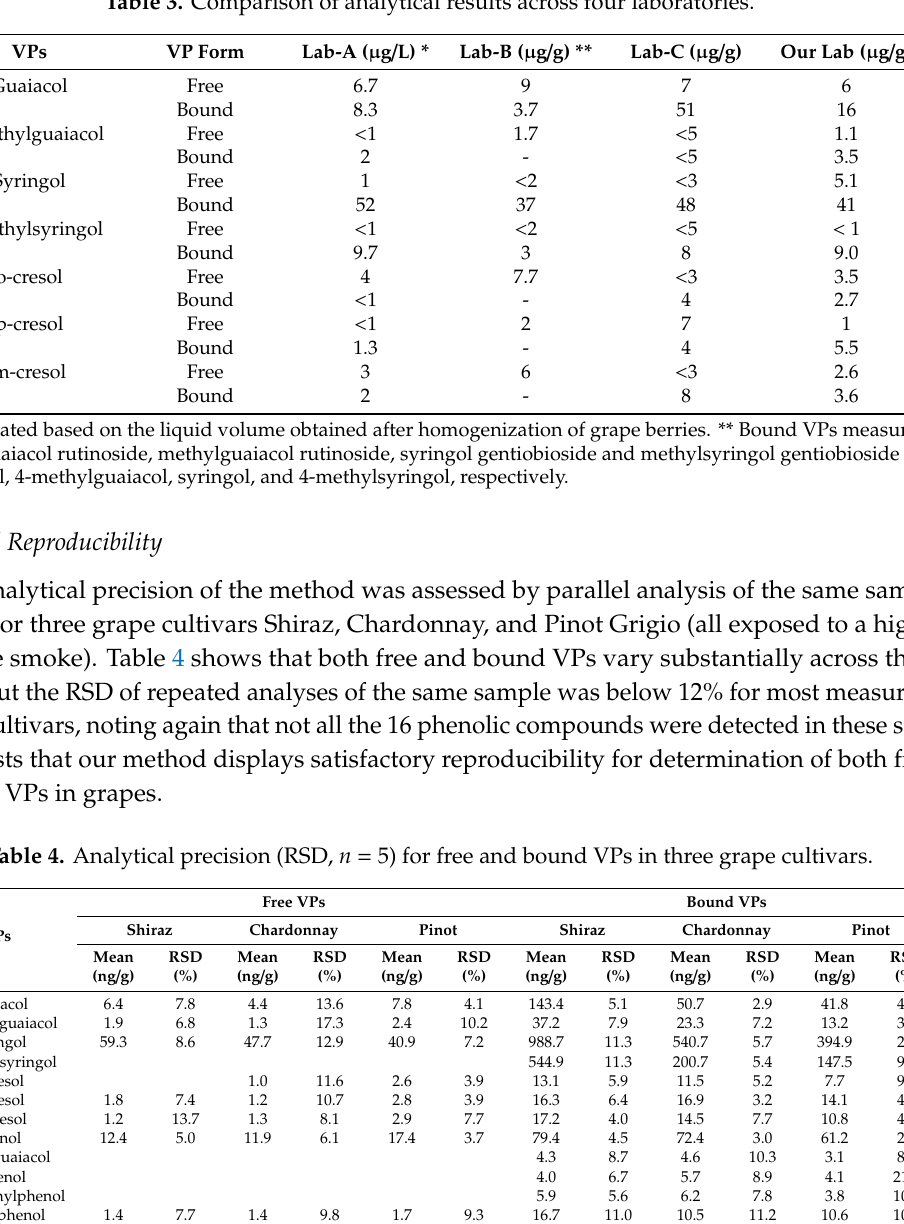
Table 3. Comparison of analytical results across four laboratories.